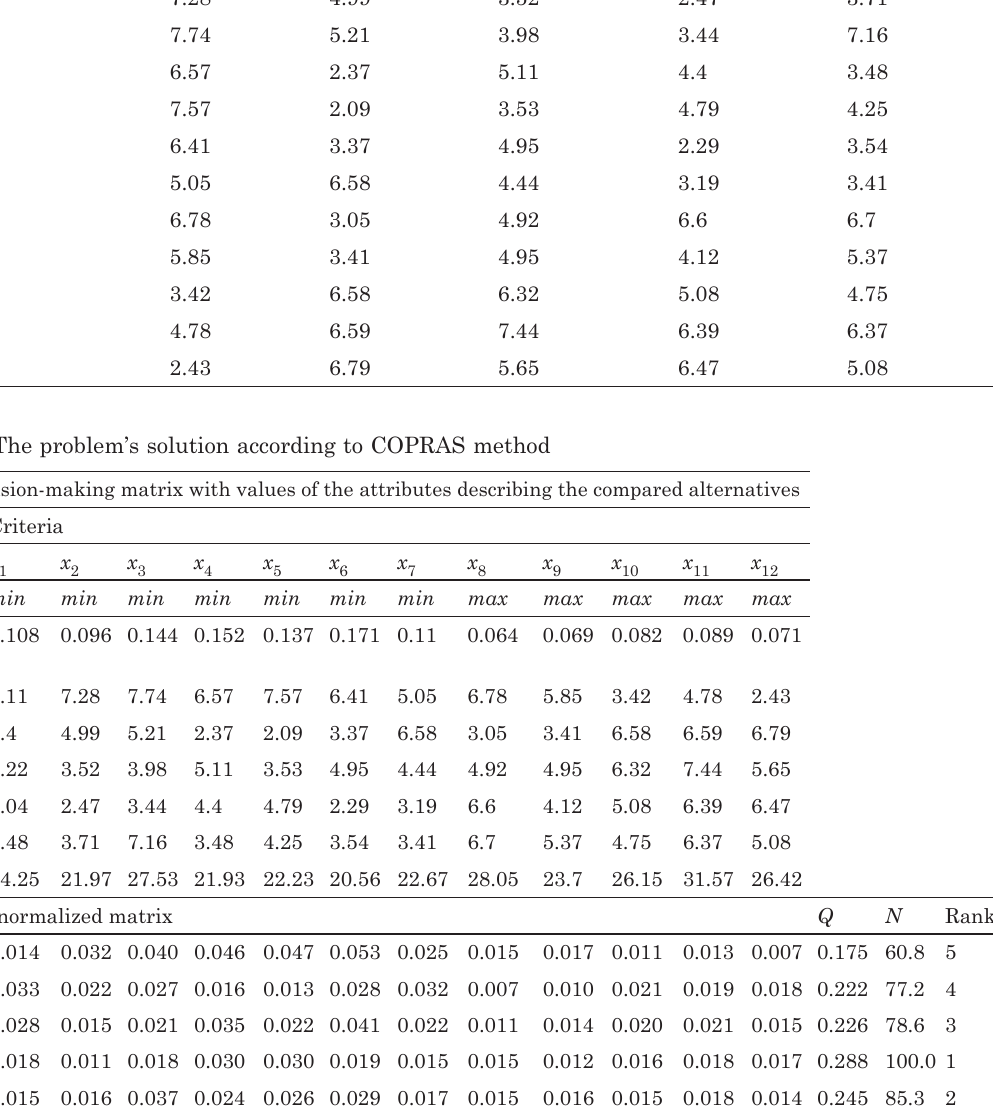
After 12-th solution step final solution results as are as shown in Table 7 and Figure